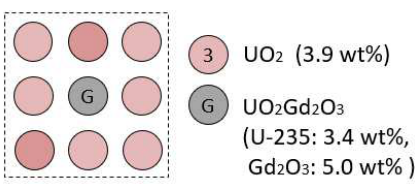
Figure 1. Geometric specification of a 3 × 3 multicell problem